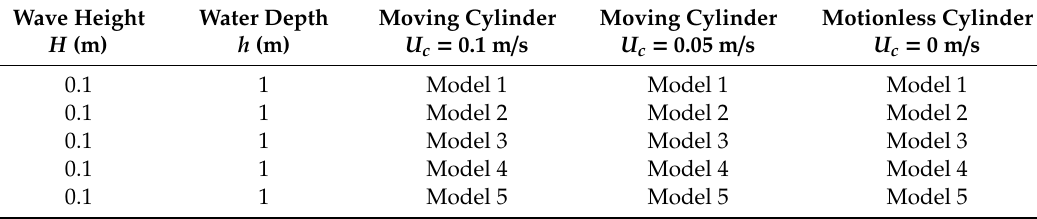
Figure 2. Detail of the models (close up of the cylinder). ( a ) Model 1, ( b ) model 2, ( c ) model 3, ( d ) model 4, ( e ) model 5. Table 1. The numerical simulations run in this study.